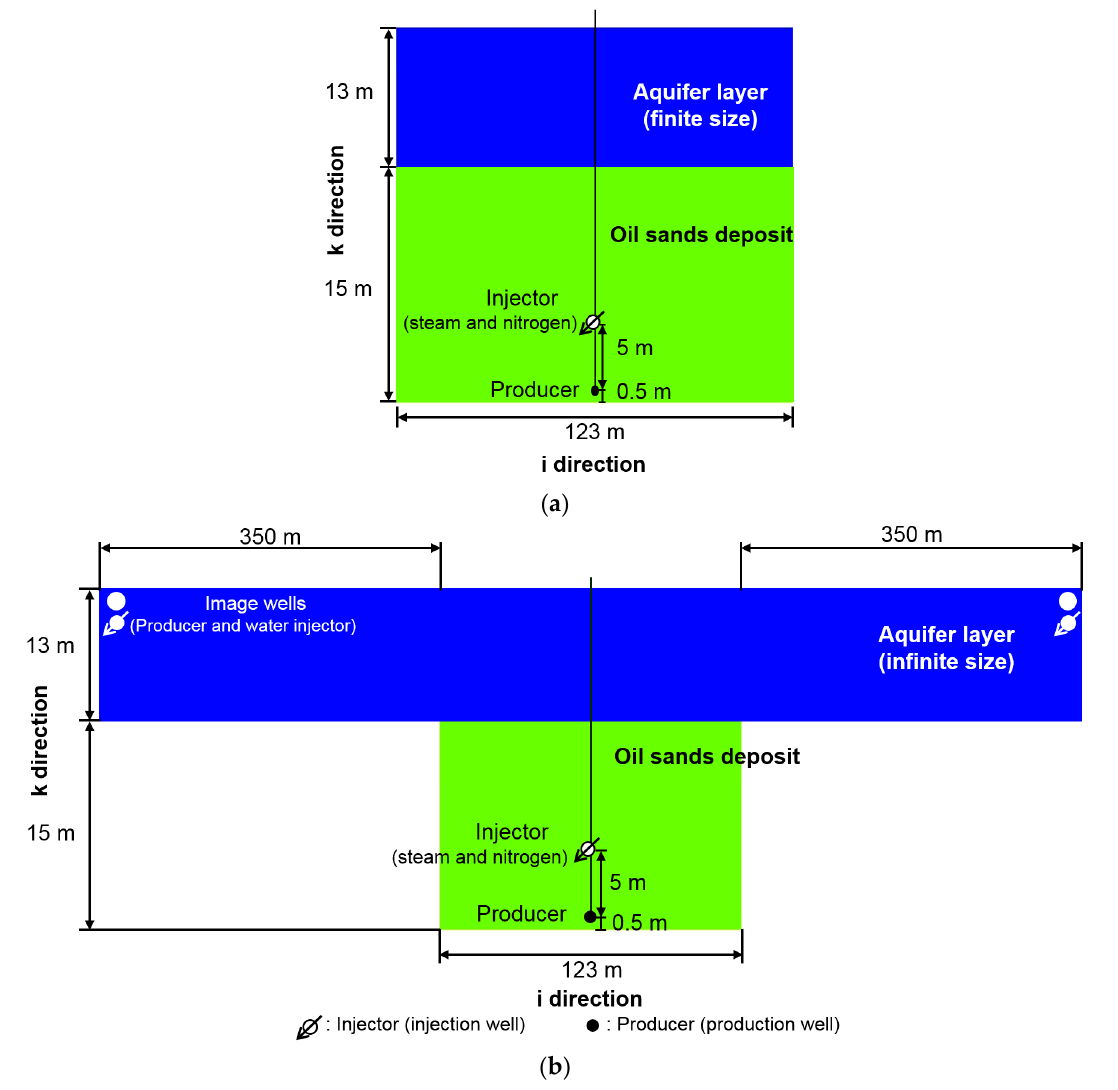
Figure 1. Schematic diagram of the synthetic models including: ( a ) the finite aquifer; and ( b ) the infinite aquifer.